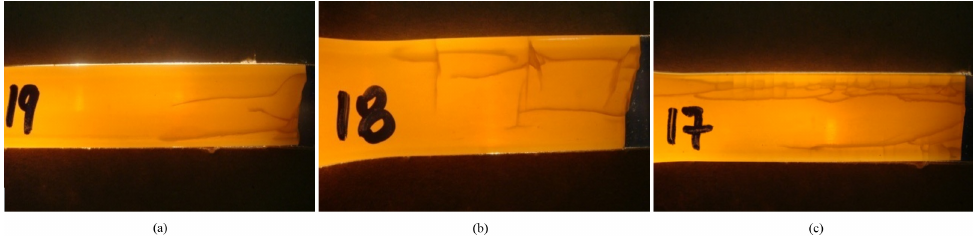
Figure 9. Macrophotographic images of sample surfaces of PHB-1 after tensile testing at 2 mm/min exposed to NaOH, preloads: (a) 275N, (b) 549N, (c) 824N.